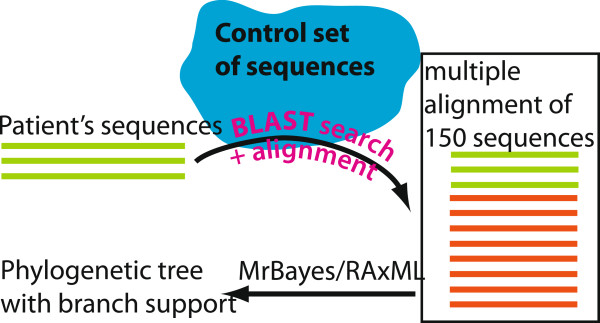
Scheme of the analysis pipeline for detecting HIV dual infection. We assembled a control sequence set for each patient by selecting, from a large sequence dataset, the highest ranking BLAST results (closest sequence matches) to each sequence of the patient, such that the total set included 150 sequences, and each sequence of the patient was matched with the same number of control sequences. Phylogenetic trees were then constructed and analyzed for each sequence set, one tree per patient.